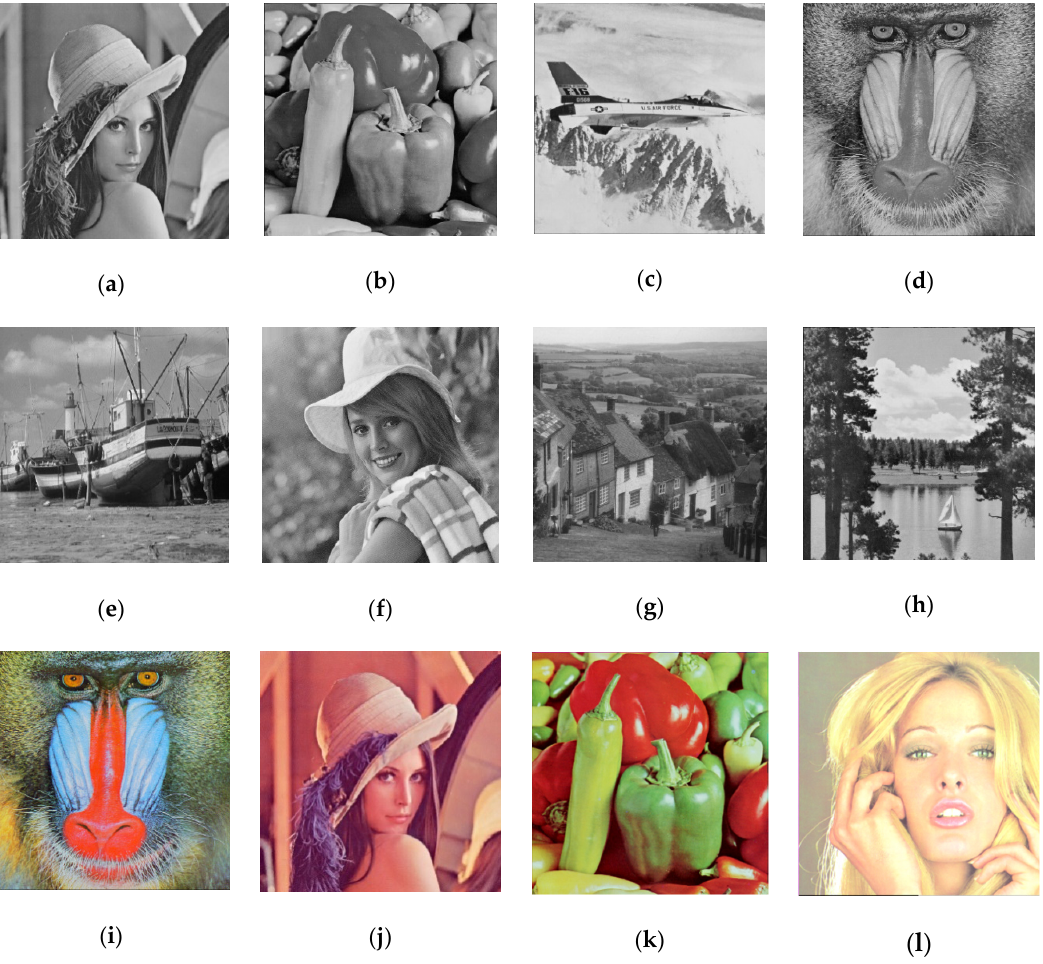
Figure 10. Twelve cover images with size 512 × 512: ( a ) Lena; ( b ) peppers; ( c ) airplane; ( d ) baboon; ( e ) boat; ( f ) Elaine; ( g ) Gledhill; ( h ) sailboat; ( i ) baboon (RGB); ( j ) Lena (RGB); ( k ) peppers (RGB); and ( l ) Tiffany (RGB).